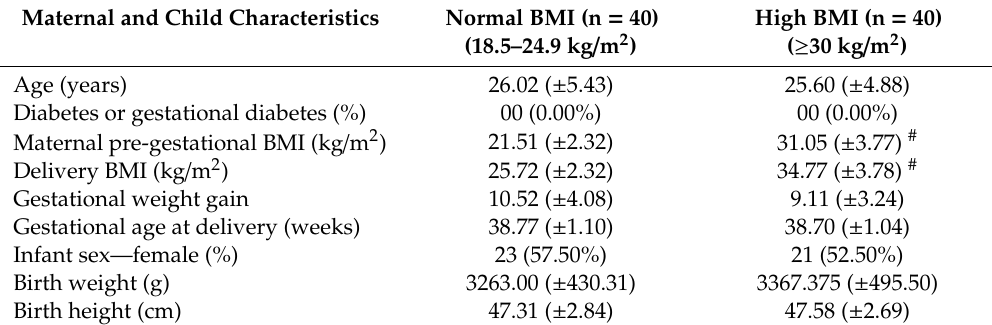
Table 1. Maternal and neonate characteristics according to maternal pre-gestational body mass index (BMI) (normal or high